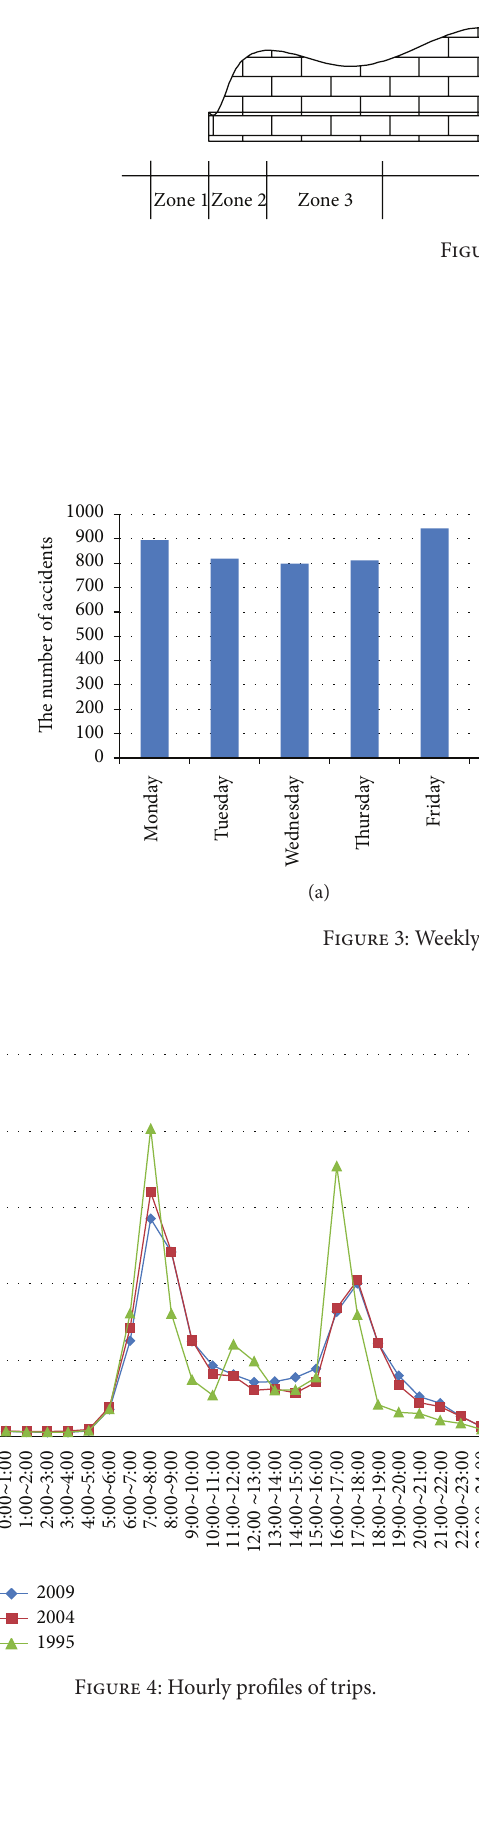
Figure 2: Tunnel zones.